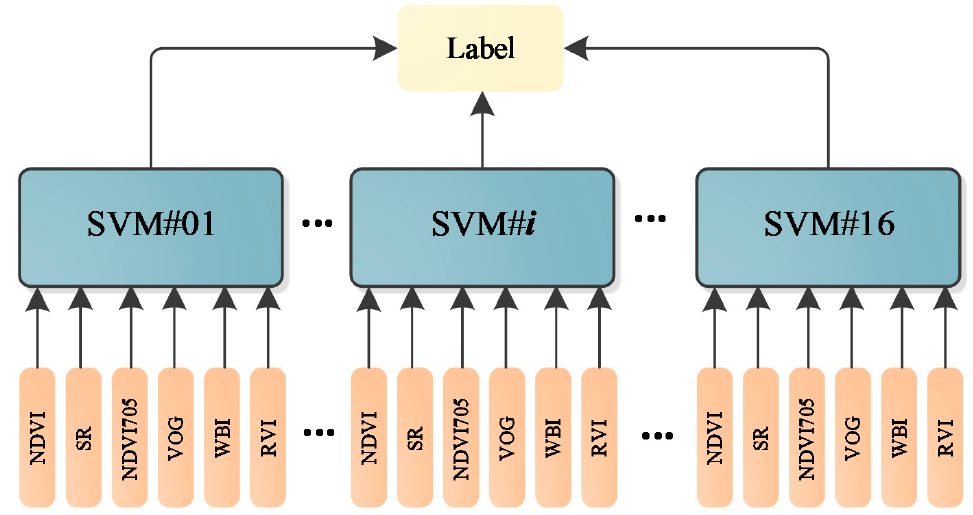
Figure 14. The multi-label SVM classifier.